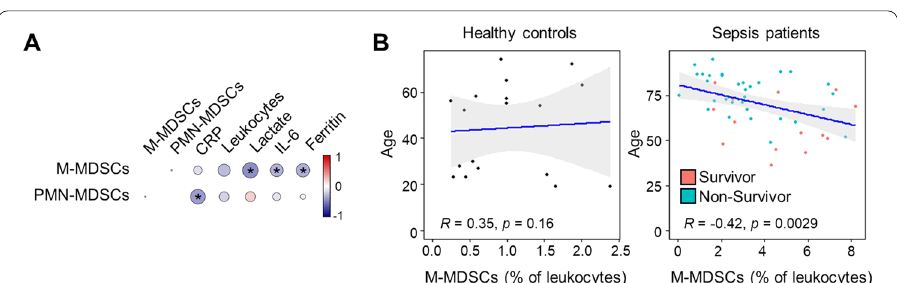
Fig. 2 A Correlation plot matrix of M‑MDSCs, PMN‑MDSCs, CRP, leukocytes, lactate, IL‑6 and ferritin levels. *M‑MDSCs inversely correlated with lactate ( ρ ( ρ 0.32, p 0.028), and PMN‑MDSCs inversely correlated with CRP ( ρ = − = M‑MDSCs (% of leukocytes) and age in healthy controls (left) and sepsis patients